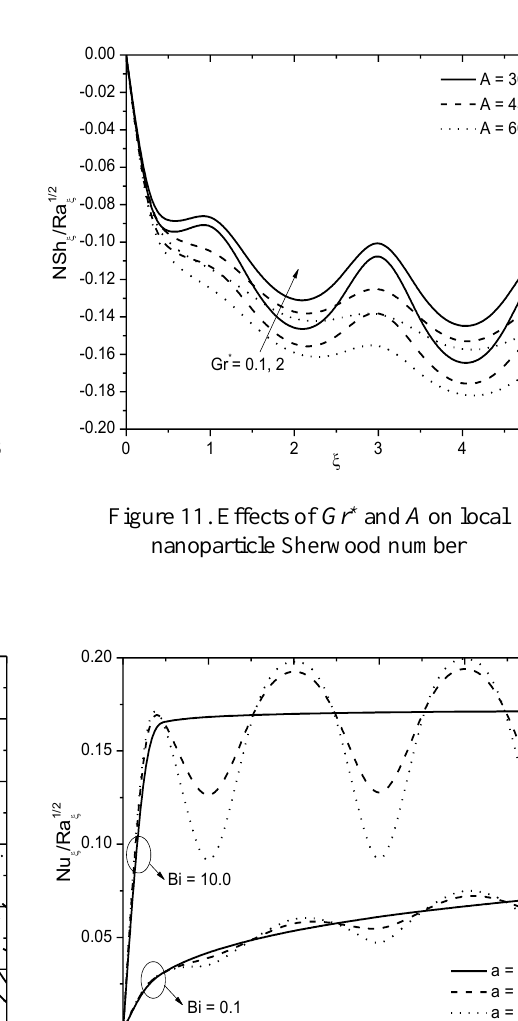
Figure 12. Effects of Gr * and A on local regular Sherwood number